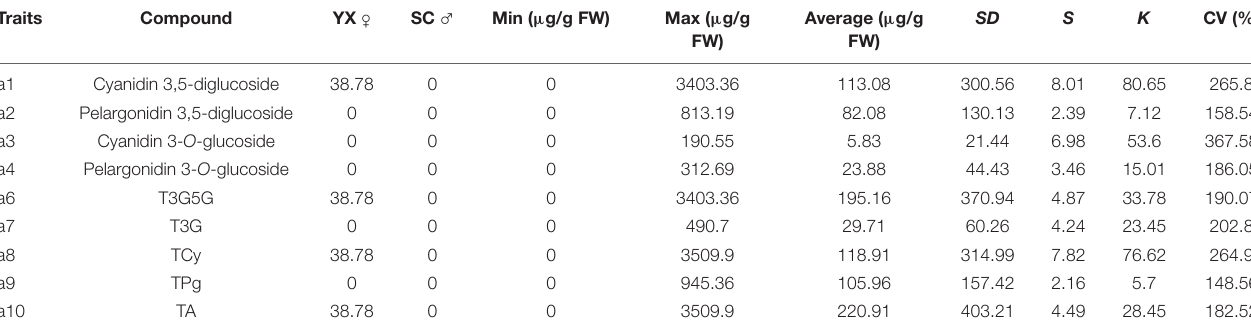
TABLE 1 | Statistical analysis of anthocyanins in the petals of parents and F 1 progeny.